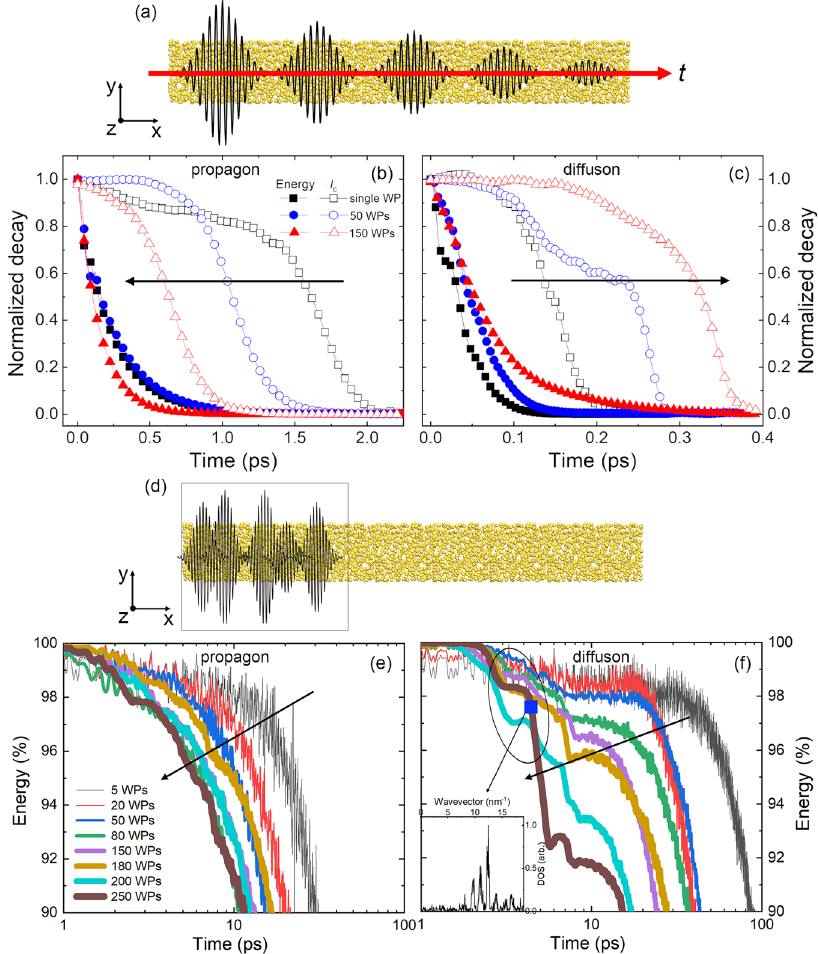
Fig. 2 Wave-packets simulation. a Schematic fi gure of wave-packets propagating in amorphous silicon. b Normalized decay trends of energy and coherence length ( l c ) versus simulation time in the cases of single-propagon wave-packet (WP), of 50 and of 150 wave-packets (WPs). c Normalized decay trends of energy and coherence length ( l c ) versus simulation time in the cases of a single-diffuson WP, of 50 and of 150 diffuson WPs. The arrows indicate the shift of l c with increasing wave-packets number. d Schematic of wave-packet excitations in amorphous silicon. The black box indicates the initial excited region with a length of 30 nm and the corresponding energy is recorded. Energy percentage versus simulation time for the different numbers of ( e ) propagon wave-packets and ( f ) diffuson wave-packets. The arrows indicate the shift of energy decrease with increasing wave-packets number. The inset in ( f ) shows the density of states (DOS) at 4 ps in the 250 wave-packets The phase correlation between different wave-packets of diffu- sons should be understood as mutual coherence 31 , which is different from the intrinsic coherence appearing in phononic or simple crystals 32 . The weak mutual coherence in Fig. 2(a) indicates that the coherence behavior of propagons here is similar to the one of phonons in simple crystals. The strong coherence of diffusons manifested by this unconverged increase of l c should greatly in fl uence the thermal energy decay and transport in a realistic system having a high density of wave-packets. The in fl uence of coherence on thermal transport is further investigated from the wave-packet simulations in Fig. 2(d – f). In this region is recorded (See the box in Fig. 2(d)). As increasing the number of wave-packets, the recorded energy change corre-